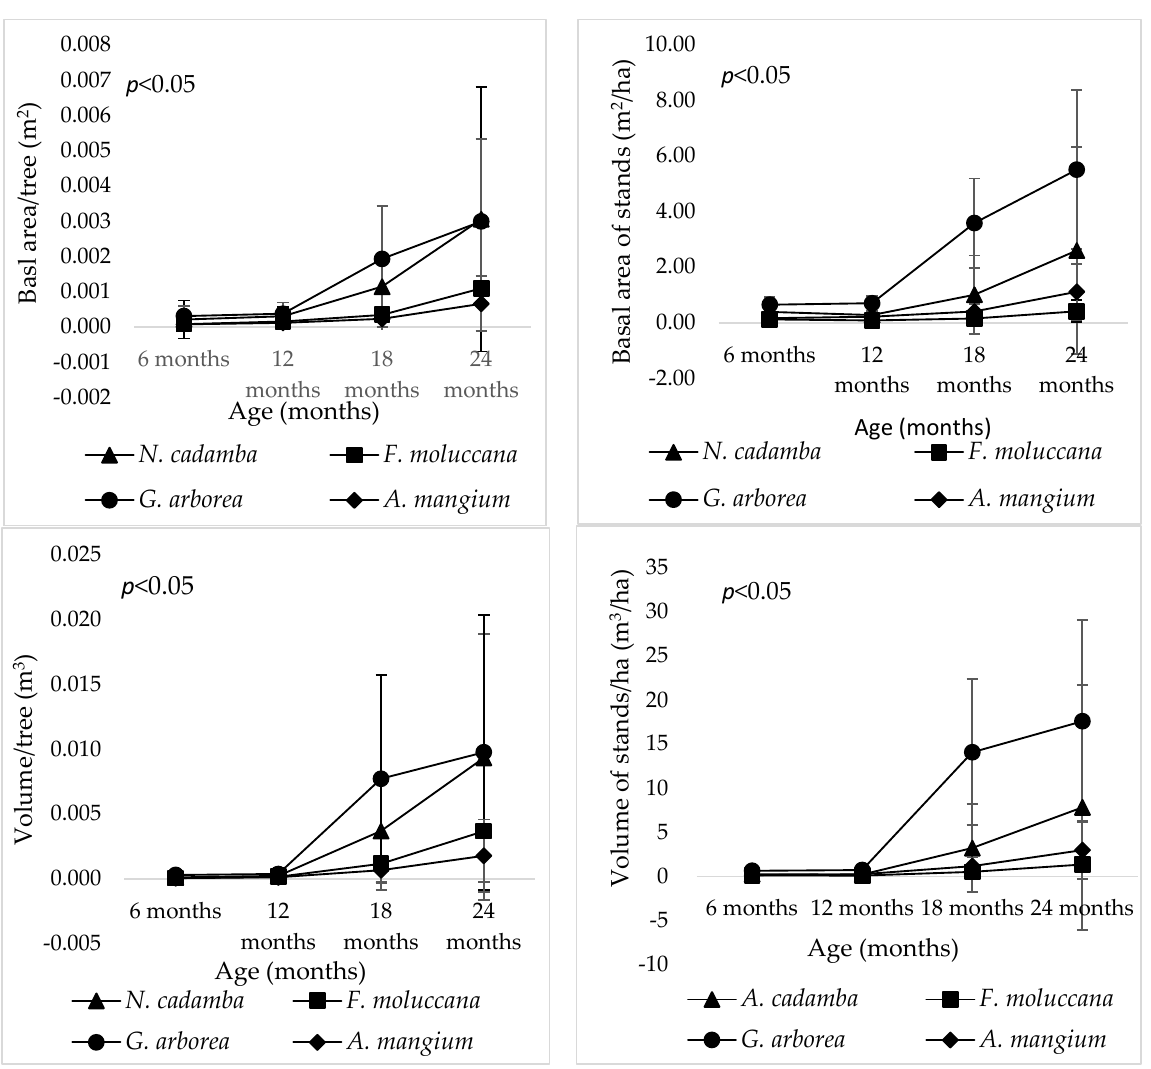
Figure 4. Basal area and volume of four fast growing tree species 24 MAP in rockydry soil of community forest, Gunungkidul, Yogyakarta (data = mean ± SD, block = 5).